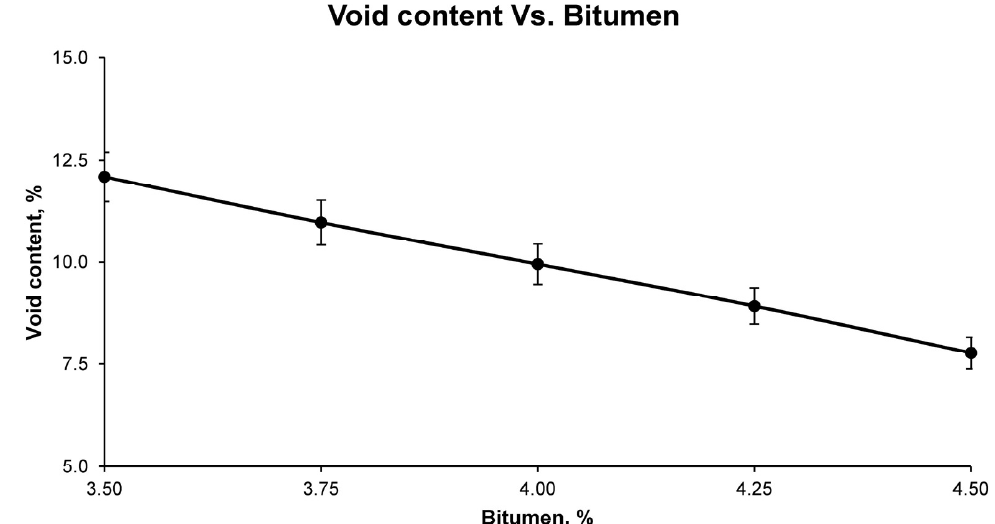
Figure 11. Void content of bituminous mixtures conforming with leaching residue and increasing percentages of bitumen emulsion.